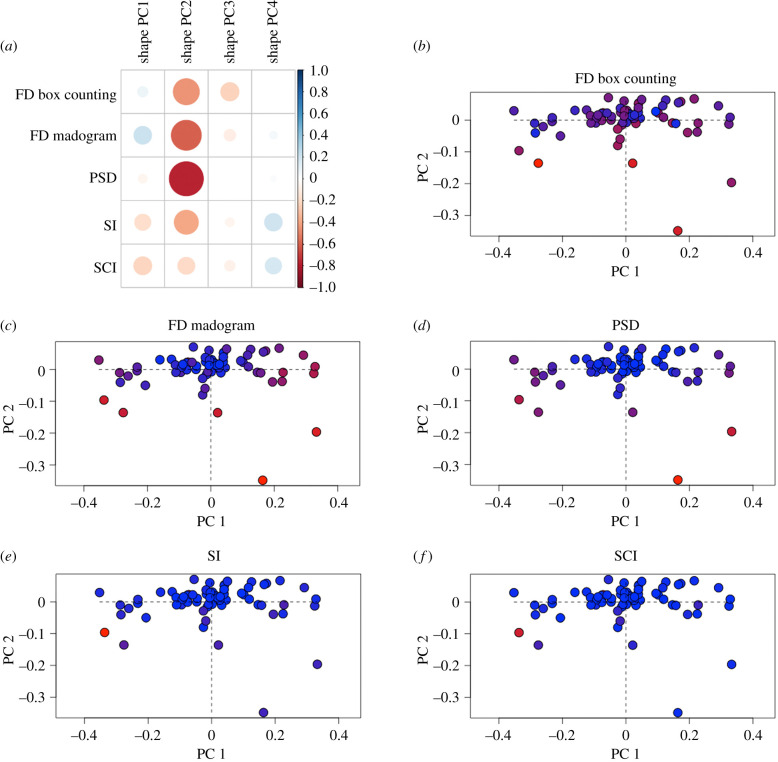
Principal components analysis of two-dimensional semi-landmark data and its relationship to the complexity methods: (a) correlation plot between the principal component scores of the shape data and the complexity scores from the five complexity metrics; (b–f) PCA of shape data with heatmaps indicating the complexity scores for FD box counting, FD madogram, PSD, SI and SCI complexity scores, respectively. Complexity scores for each of the five methods were subdivided into 10 equal bins to define the heatmap colour associations, with red indicating the most complex sutures and blue indicating the least complex sutures.